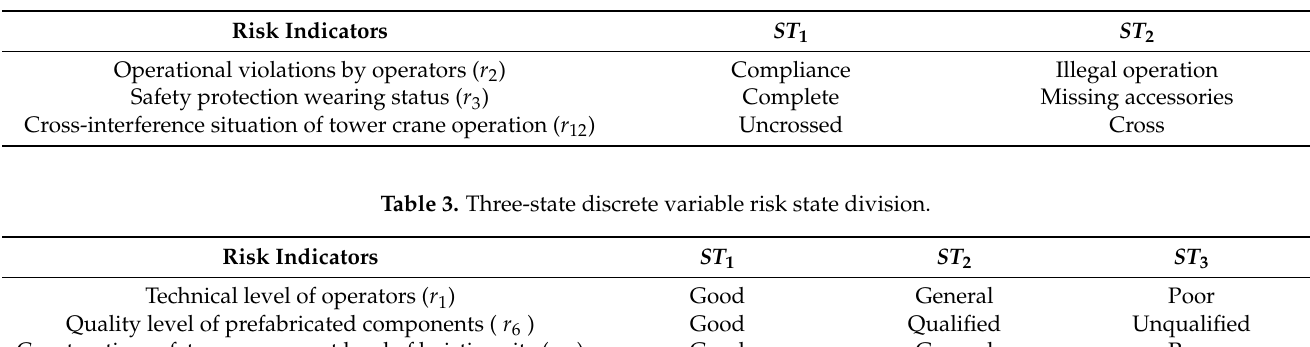
Table 2. Two-state discrete variable risk state division.